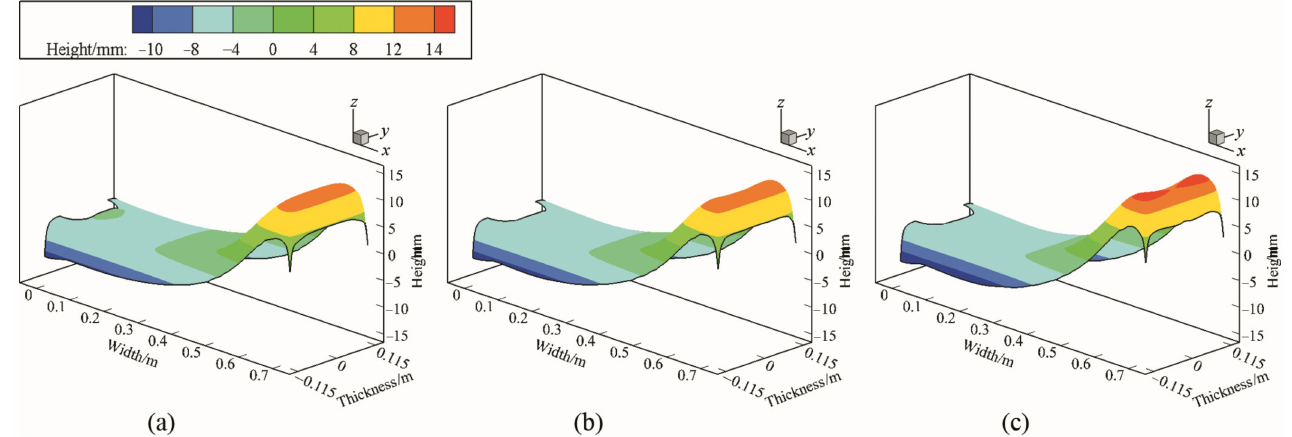
Figure 13. Steel–slag two–phase interface fluctuation profiles in the mold with various positions of the ruler EMBr: ( a ) H 1 = 225 mm, ( b ) H 2 = 255 mm, and ( c ) H 3 = 285